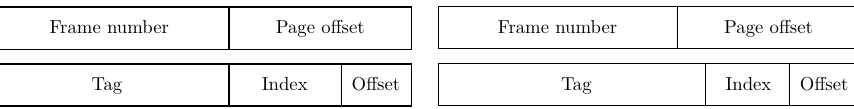
Figure 3: Physical-to-cache address translation in virtually indexed caches.